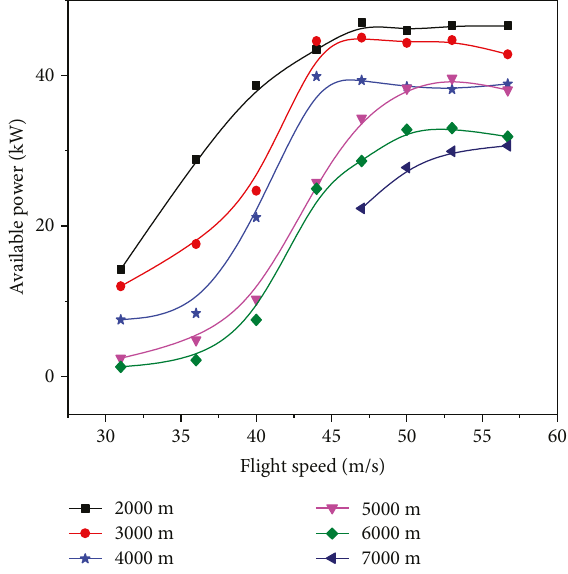
Figure 12: Curves of available power at di ff erent